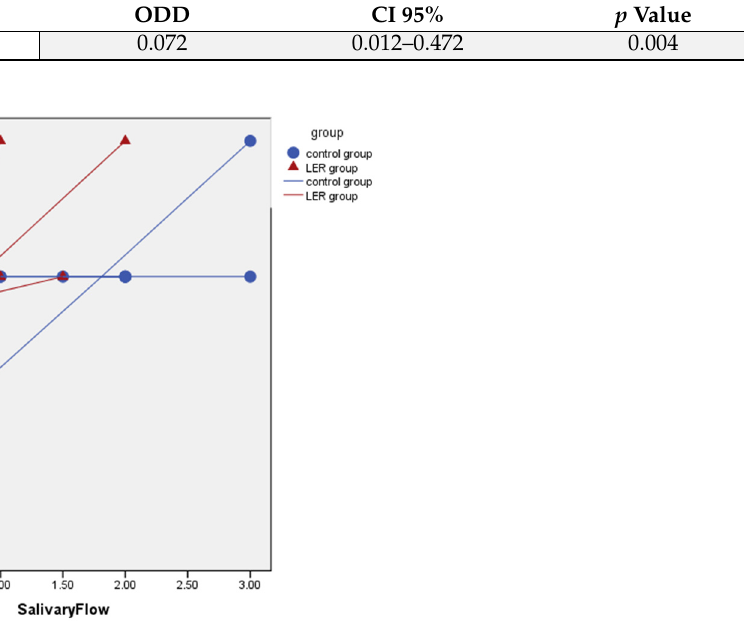
Table 5. Increased salivary flow was found to be a statistically significant protective factor from having laryngeal reflux. Figure 4. Salivary flow demonstrated excellent accuracy in identifying Group A membership, with an AUC of 0.915.